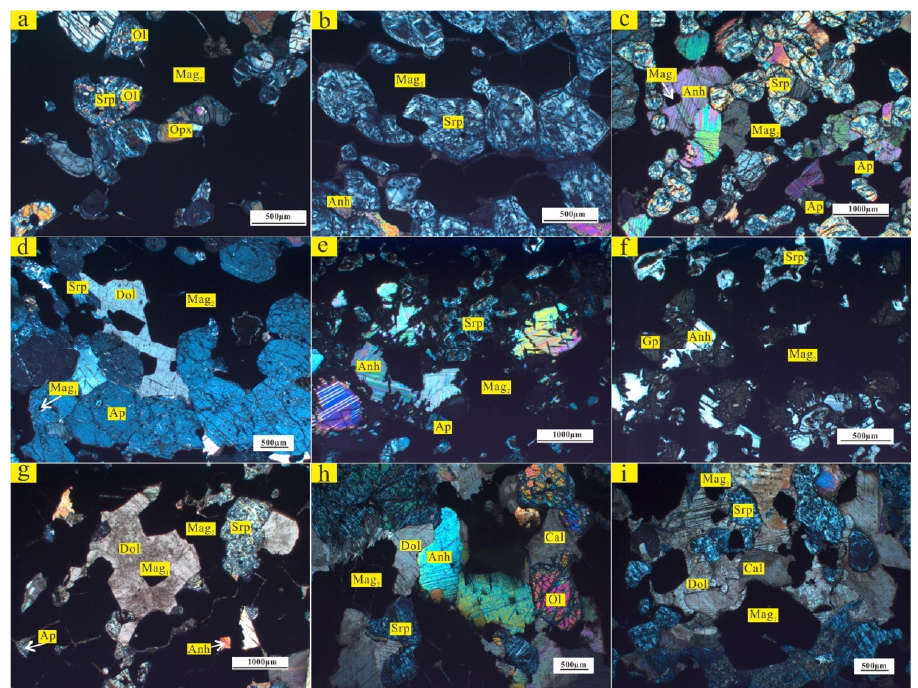
Figure 3. The mineral assemblages of the di ff erent types of iron ores in the Zhaoanzhuang iron deposit. ( a ) Dense disseminated serpentine–magnetite ore with residual olivine and orthopyroxene. ( b ) Banded serpentine–magnetite ore with minor anhydrite. ( c ) Disseminated serpentine–magnetite ore with abundant anhydrite and minor apatite. ( d ) Apatite–magnetite ore with irregular dolomite and minor serpentine. ( e ) Anhydrite–magnetite ore with serpentine and minor apatite. ( f ) Anhydrite–magnetite ore with serpentine. ( g ) Carbonate–magnetite ore with serpentine, apatite, and anhydrite. ( h ) Carbonate–magnetite ore containing magnetite, olivine, serpentine, anhydrite, dolomite, and calcite. with magnetite and serpentine. ( i ) Carbonate–magnetite ore with serpentine. Abbreviations: Anh, anhydrite; Ap, apatite; Cal, calcite; Dol, dolomite; Gp, gypsum; Mag, magnetite; Ol, olivine;